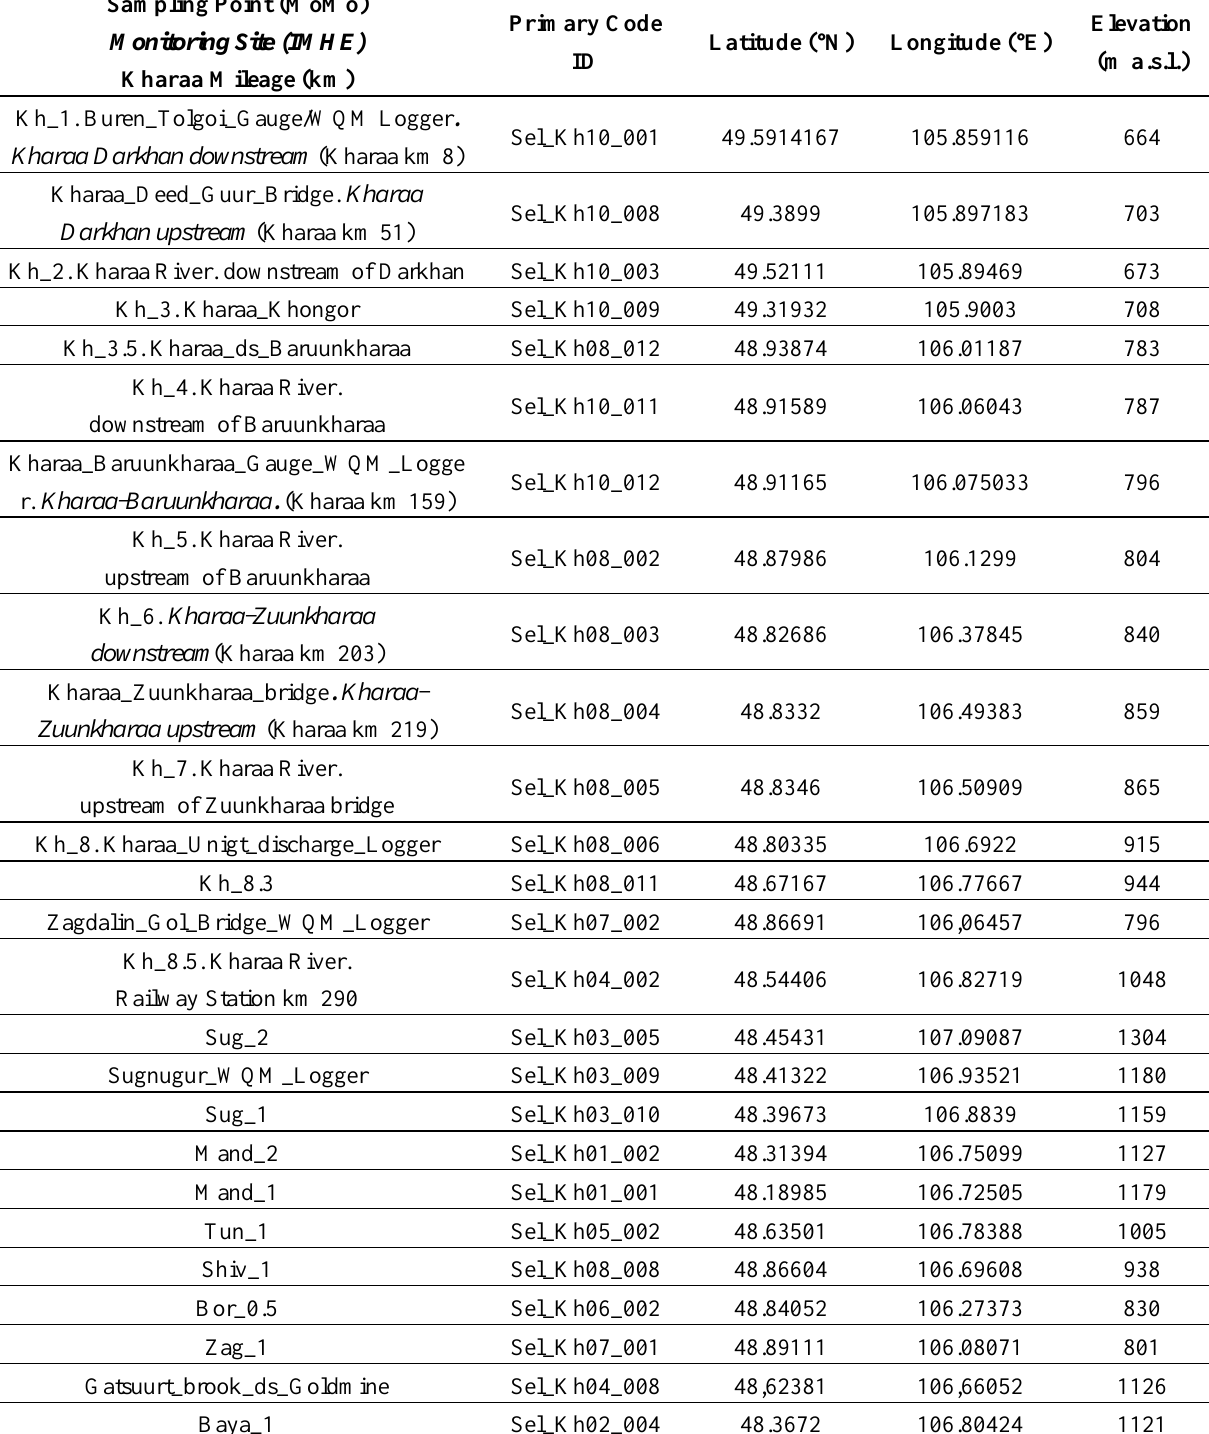
Table 1. Sampling points for hydromorphology, discharge, physico-chemistry, macroinvertebrates, diatoms and fish. The unequivocal primary code ID (second column from left) allows the allocation of systematic site names for all locations (e.g., Sel_Kh10_001; Sel = Selenge River basin district. Kh = Kharaa river basin, 10 = Sub-basin 10 of KRB [15], 001 = numbers of water bodies and water usages (001–200 = Surface water bodies of running waters, e.g.,